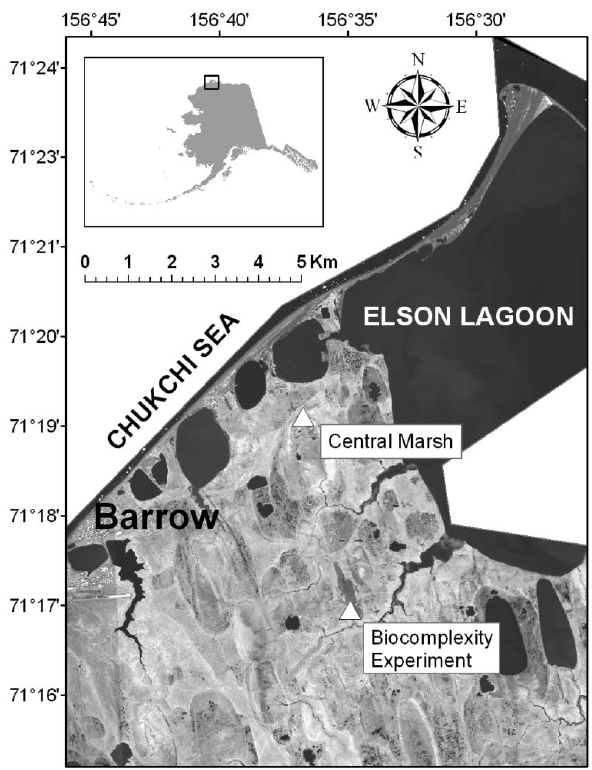
Fig. 1. The Central Marsh (CM) and the Biocomplexity Experi- ment (BE) sites are located at separate vegetated, drained thaw lake basins within 3km of the ocean, outside the town of Barrow, North- ern